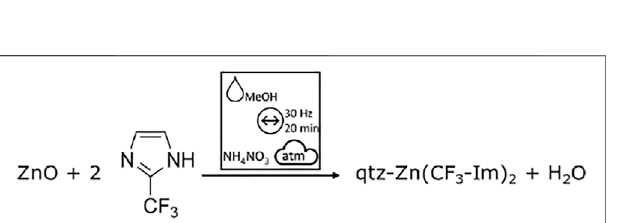
FIGURE 3 | In situ XRD plot of the formation of SOD-Zn 0.9 Co 0.1 (2Me-Im) 2 (center). For comparison, the simulated XRD patterns of starting materials (bottom) and the product (top) are shown, as well as the intensities of selected re fl ections of each present phase.